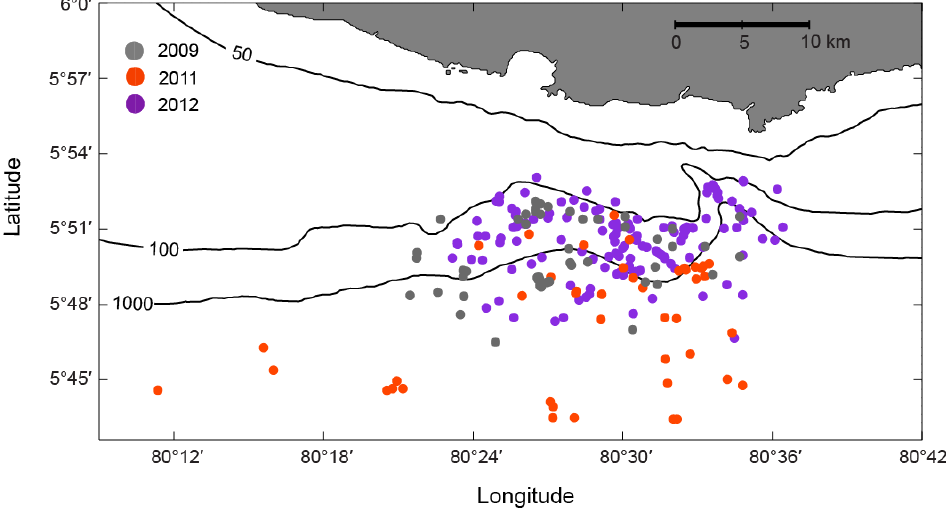
Figure 6. Blue whale sightings from 2009 (grey), 2011 (orange) and 2012 (purple). Each dot represents an individual sighting. All sightings were from first encounter of an individual on each